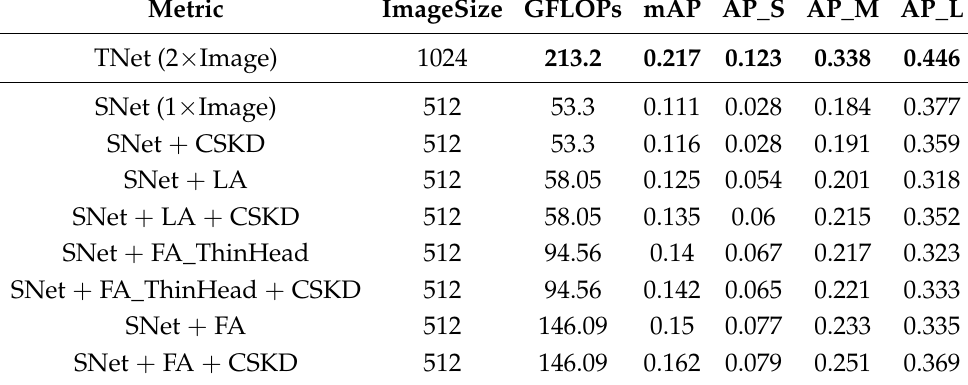
Table 3. Ablation experiment of distillation results. Layer Adaption (LA) and Feature Layer Align- ment (FA) are used to align the output feature maps of the student net (SNet) and the teacher net (TNet), and then cross-scale knowledge distillation (CSKD) is carried